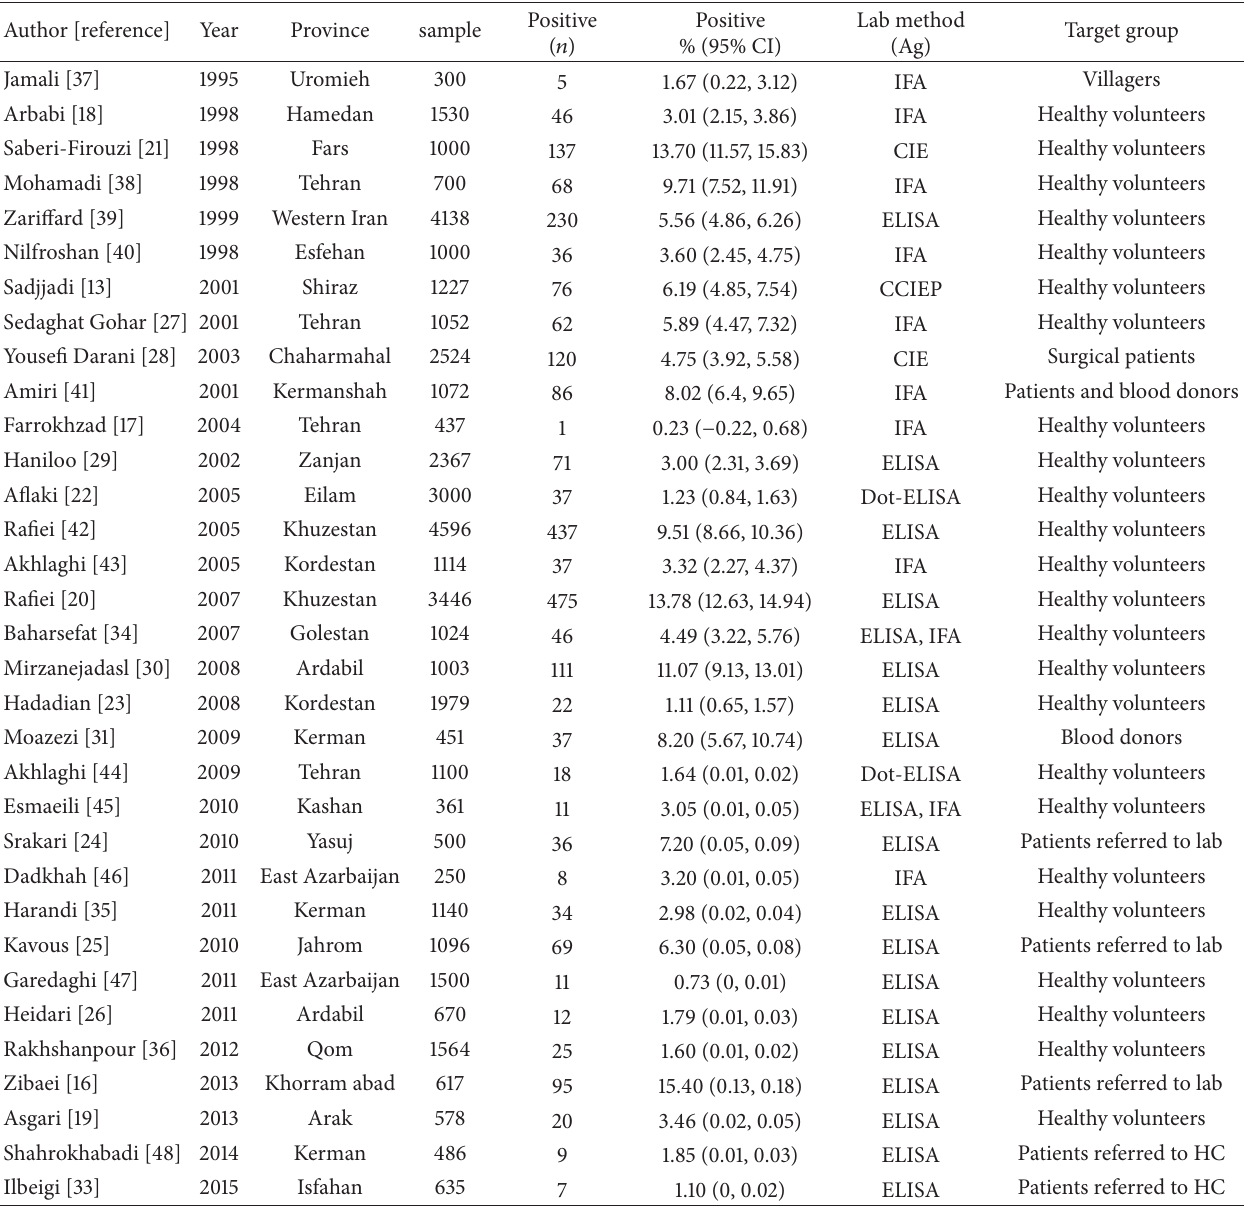
Table 1: General characteristics of studies included in the present systematic review and